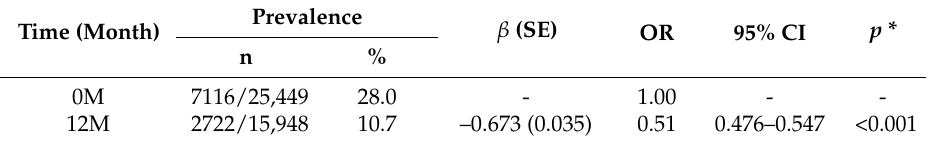
Table 5. Changes in prevalence of metabolic syndrome over the SMESY intervention ( N = 25,449). Prevalence β (SE) OR 95% CI p * Time (Month) n % 0M 7116/25,449 28.0 - 1.00 - - 12M 2722/15,948 10.7 –0.673 (0.035) 0.51 0.476–0.547